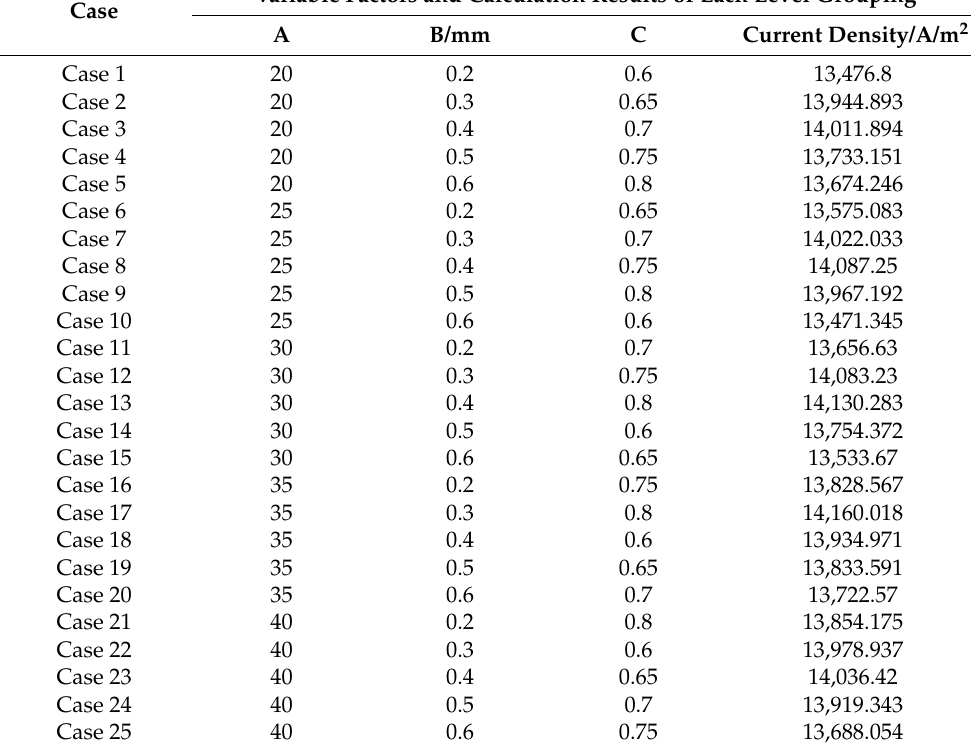
Table 4. List of orthogonal